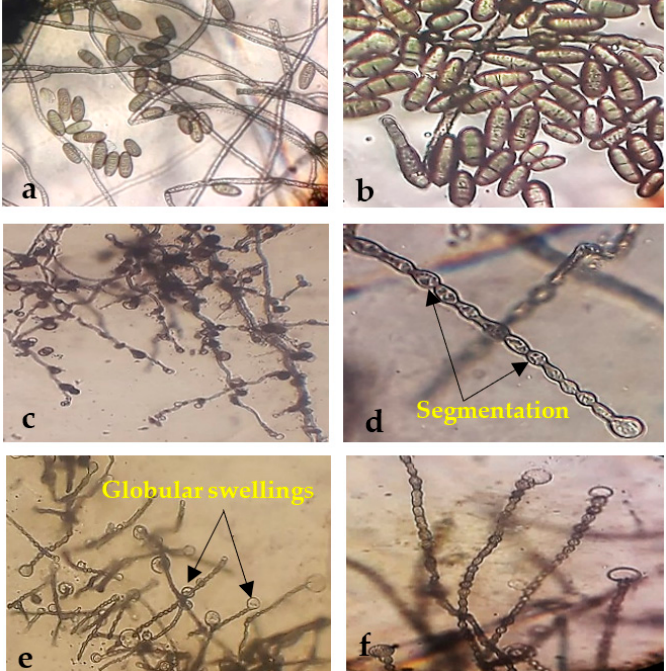
Figure 6. Morphological abnormalities in the mycelia of Helminthosporium sp. upon interaction with endophytic bacteria. Images ( a , b ) are the untreated (control) Helminthosporium sp. mycelia and spores. ( c , d ) show the swelling and deformity of Helminthosporium sp. mycelia treated with B. velezensis . ( e , f ) were representatives of swelling, segmentation, and deformation of Helminthosporium sp. mycelia treated with B. amyloliquefaciens